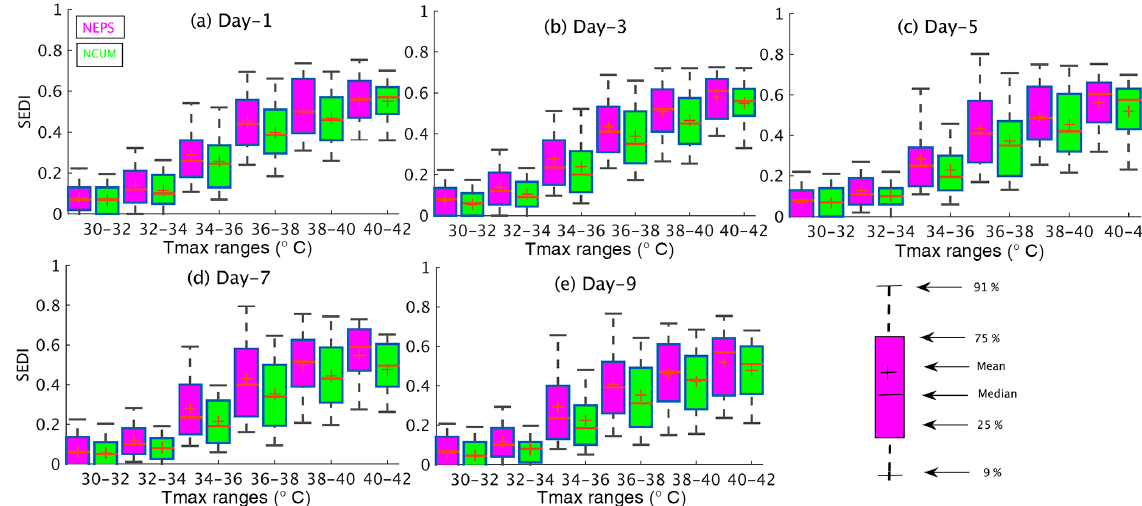
Figure 13. Box plots (a–e) for symmetric extremal dependence index (SEDI) for NCUM and NEPS from March to May 2016 (NCUM stands for NCMRWF unified model and NEPS stands for NCMRWF ensemble prediction system). SEDI values are higher in NEPS forecasts for all temperature ranges and for all lead times compared to NCUM forecasts, suggesting improved performance of NEPS at all temperature